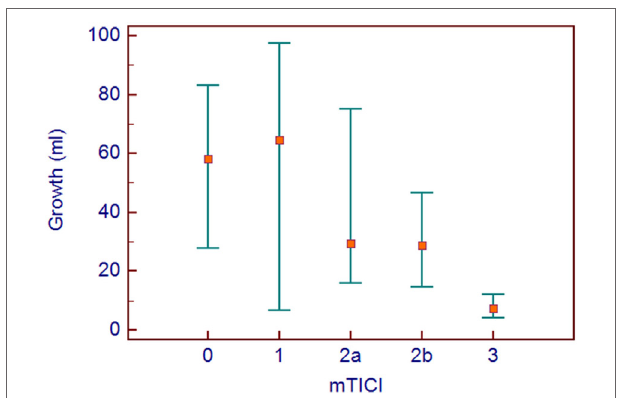
FigUre 3 | Median growth with interquatile ranges are shown for the modified thrombolysis in cerebral infarction